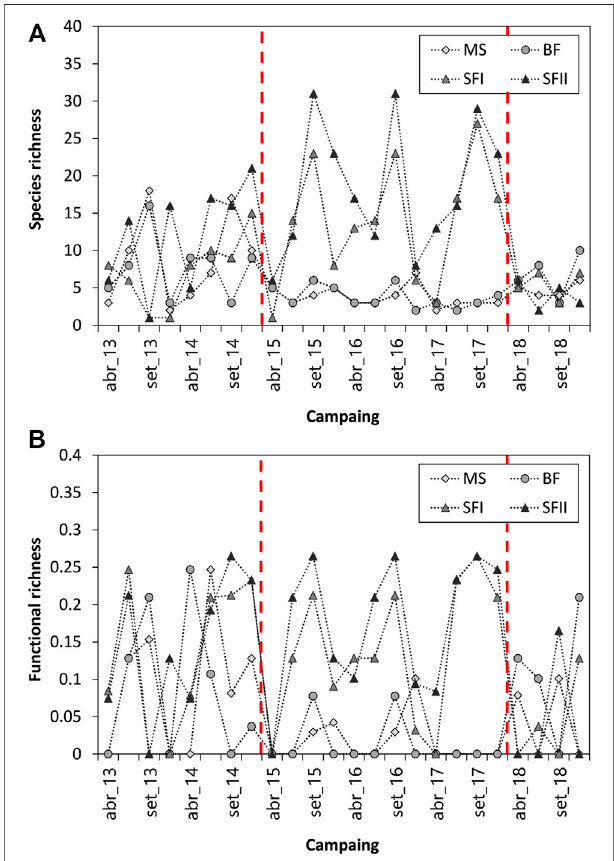
FIGURE 5 | Temporal variation of phytoplankton (A) Species richness and (B) Functional richness (FRic) sampled from 2013 to 2018 in the three Small Hydroelectric Power Plant (SHP) reservoirs: Monte Serrat (MS; n = 24), Bonfante (BF; n = 24) and Santa Fé (SF I and II; n = 24). The red dashed lines indicate the periods of signi fi cant changes in the dominance of the main phytoplankton groups.